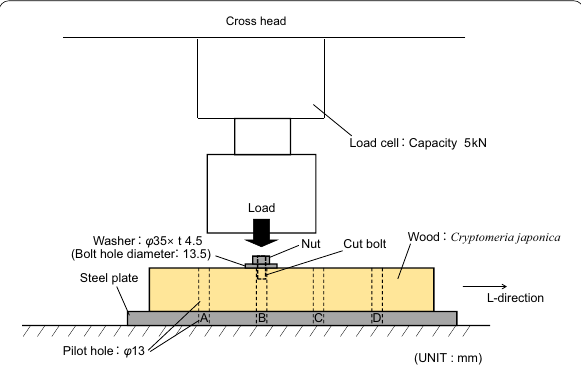
Fig. 3 Schematic of the apparatus for the embedment test of metal washers (L: